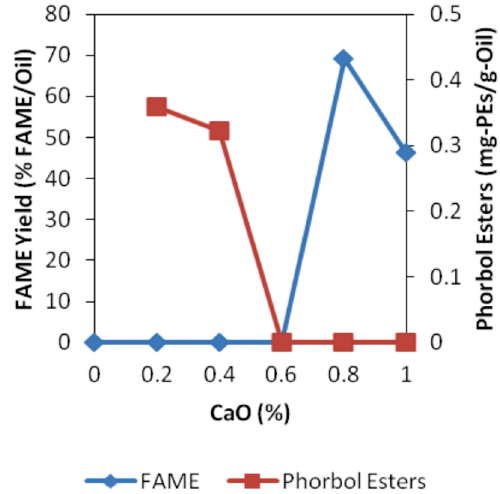
Fig. 3. Effect of CaO concentration on FAME yield and phorbol esters in the reaction products in solid alkaline catalyzed transesteri fi cation.